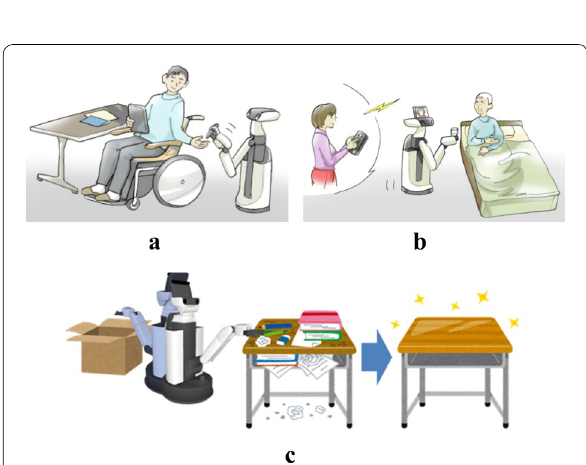
Fig. 3 Utilization of HSR [19]. a Independent living support, b Remote care support, c Housework